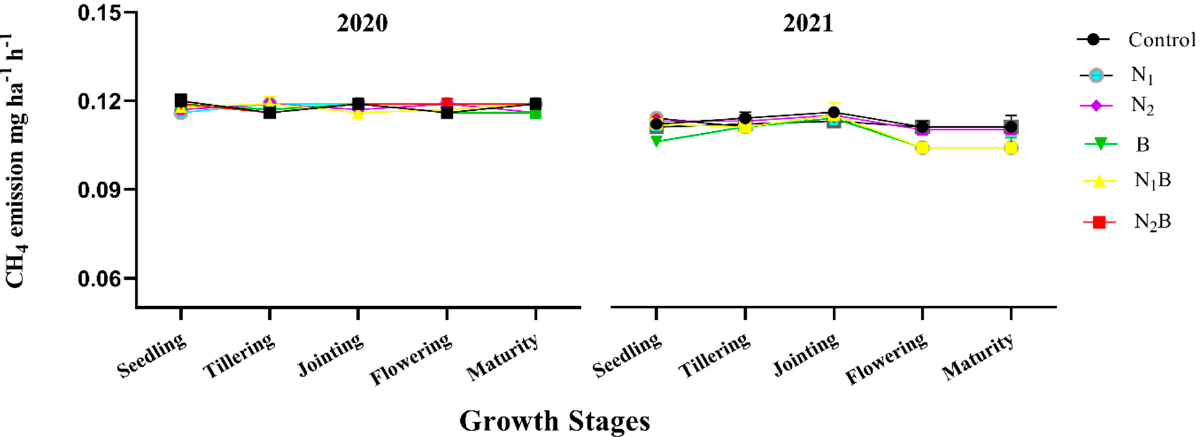
Figure 4. Direct effect of biochar on CH 4 emissions at different growth stages of spring barley (2020) and after effects on pea crop (2021). Treatments: control-without amendments; N 1 -160 kg ha − 1 nitrogen fertilizer; N 2 -120 kg ha − 1 nitrogen fertilizer; B-25 t ha − 1 biochar; N 1 B-160 kg ha − 1 nitrogen fertilizer plus 25 t ha − 1 biochar; N 2 B-120 kg ha − 1 nitrogen fertilizer plus 25 t ha − 1 biochar.